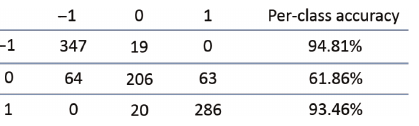
Figure 28: Training Confusion Matrix of Experiment 3.